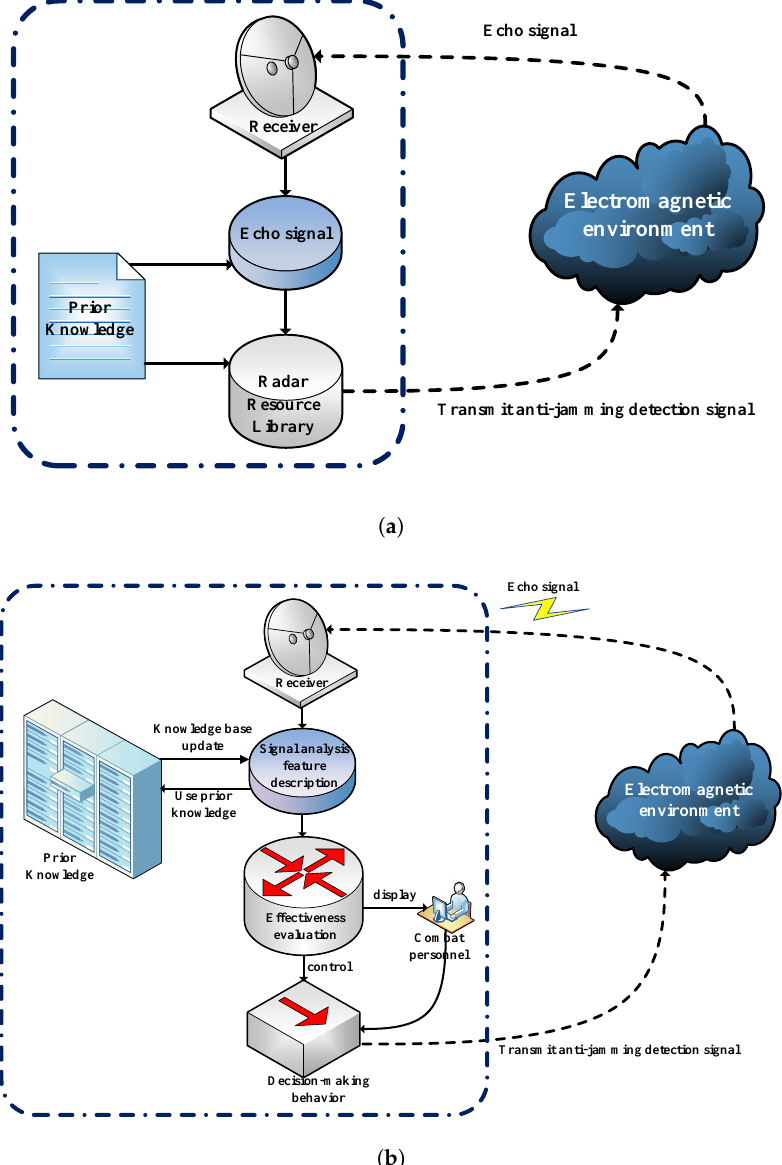
Figure 2. Comparison chart of radar system anti-jamming process. ( a ) Traditional radar anti-jamming model, ( b ) Intelligent radar anti-jamming